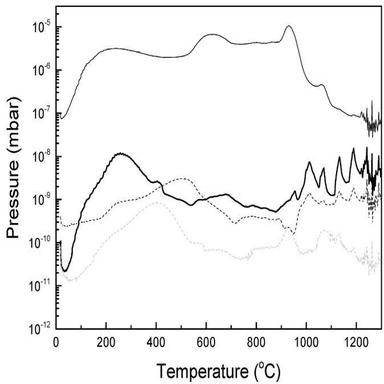
RGA traces with bearing on NO identification: m/z = 30 (thick solid line), m/z = 14 (dashed black line) and m/z = 31 peaks (dashed grey line). The m/z = 18 water peak (thin solid line) is shown for scale.